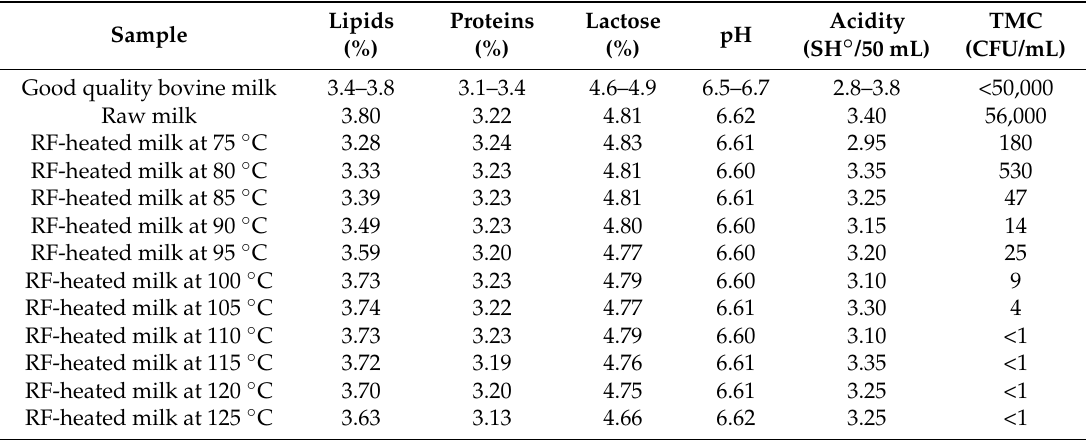
Table 3. Physicochemical and microbiological parameters for good quality bovine milk, raw milk and RF-heated